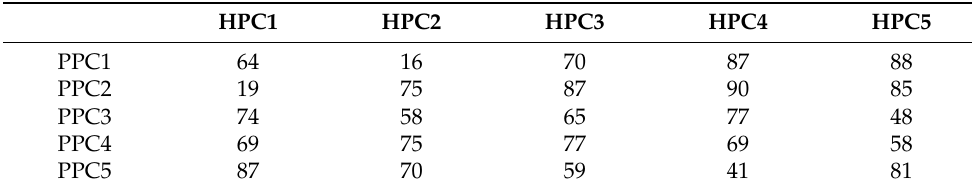
Table 3. Level of similarity in angles (degrees) between synergies. H and P stand for healthy and pathologic subjects, respectively (lower angles represent more similarity, and angles close to 90 ◦ represent no similarity at